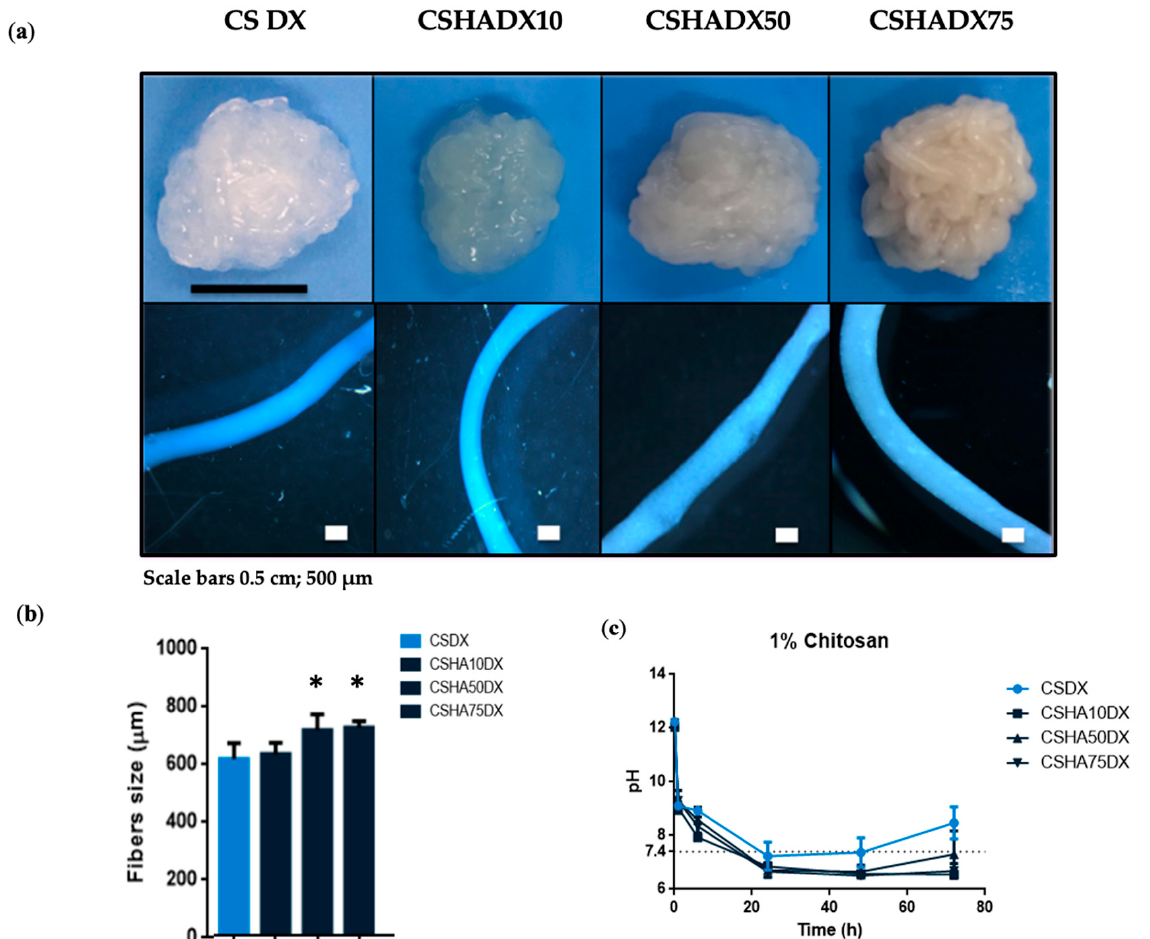
Figure 4. ( a ) Digital photographs and optical microscope images of 1% CS fibers manufactured with a needle diameter of 0.9 mm and at a constant rate of 75 mL/h mixed with different concentrations of HA (0–75%) with DX incorporation. Scale bars 0.5 cm and 500 µm. ( b ) CSHA fibers size with DX incorporation. Data are shown as mean ± standard deviation ( n = 6). (* p < 0.05). ( c ) pH analysis of 1% CS at a constant rate of 75 mL/h with different HA concentrations (0–75%) and DX addition ( n = 3).